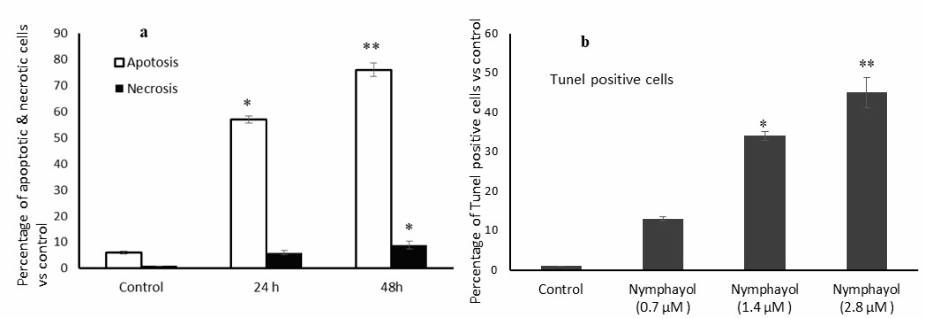
Figure 4. The percentage of apoptotic and necrotic cells after 48 h of nymphayol treatment is shown in ( a ). The TUNEL positive cells of nymphayol treated MCF-7 cells are shown in ( b ). Data are presented as the means ± SD (n = 6). Values sharing a common superscript as ** p ≤ 0.001 compared with the vehicle control, * p ≤ 0.01 compared with the vehicle